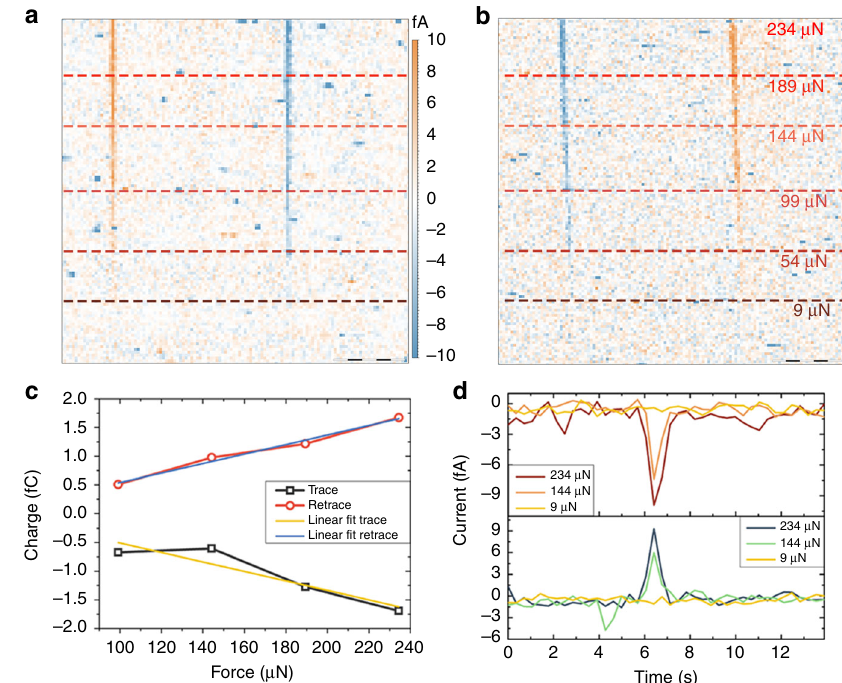
Fig. 3 Force dependence for the piezogenerated charge mapping. a DPFM-Si and b DPFM-So of the proposed PPLN test sample, obtained at different applied forces, scale bar 5 μ m. In order to demonstrate the origin of the recorded current, different forces where applied during the scan-see red line dot. The current recorded increases with the applied force, as expected from a piezoelectric charge generation. c charge vs force spectroscopy sweep obtained from the pro fi les of Fig. 3a. The current pro fi les where integrated with a time constant of 390 ms in order to obtain the charge generated at a speci fi c pixel. The linear relation displayed between force and collected charge con fi rms the piezoelectric nature of the generated charge. d current pro fi les extracted from Fig. 3a for different applied forces. Applying 9 μ N is not enough to read the current generated as it lies below the current threshold of the ampli fi er. As the force is increased, the ampli fi er responds to the generated